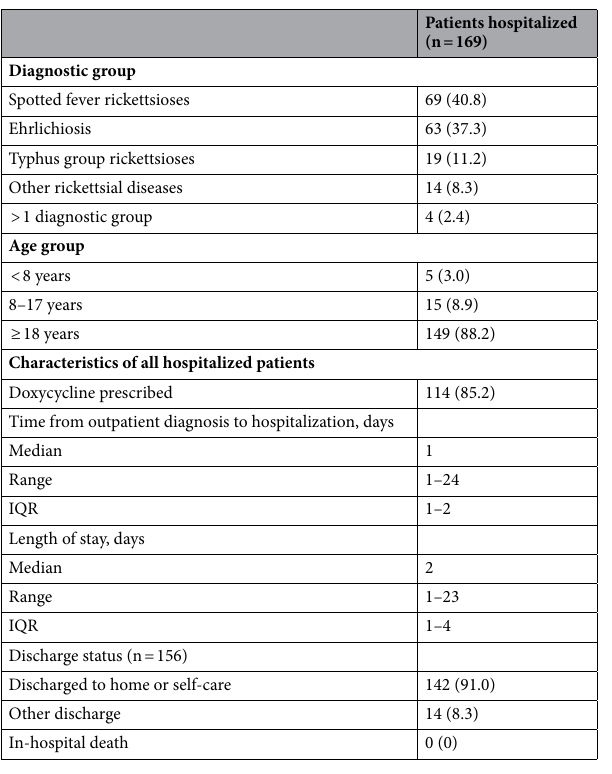
Table 3. Characteristics of outpatients with a rickettsial disease-associated hospitalization within 30 days following index date in a large, commercially insured population — United States, 2005–2017. Data are presented as No. (%) unless otherwise